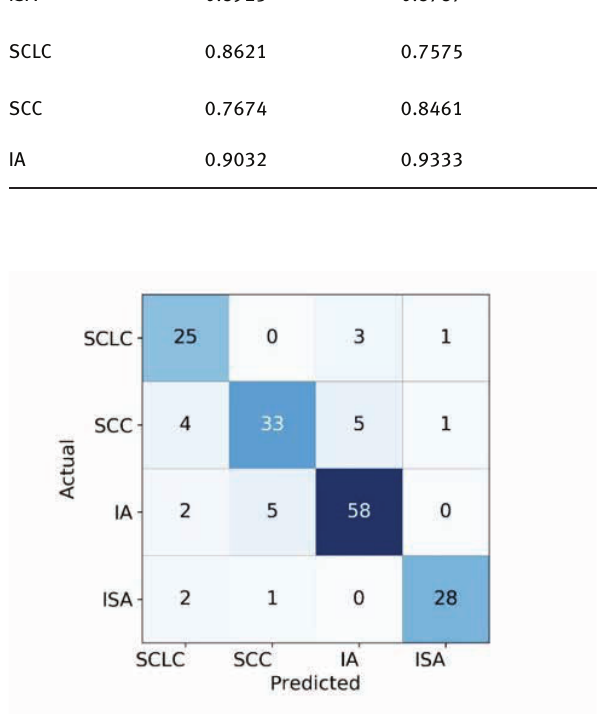
Figure 6: Confusion matrix of test result.